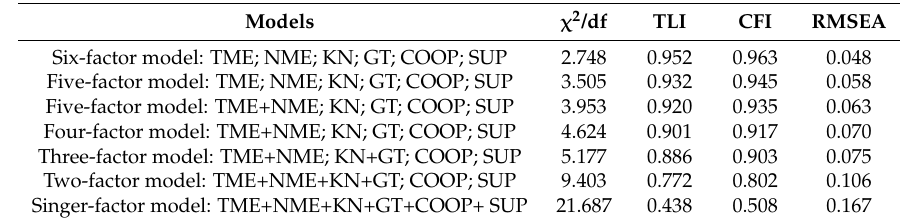
Table 2. Results of the confirmatory factor analysis (CFA).